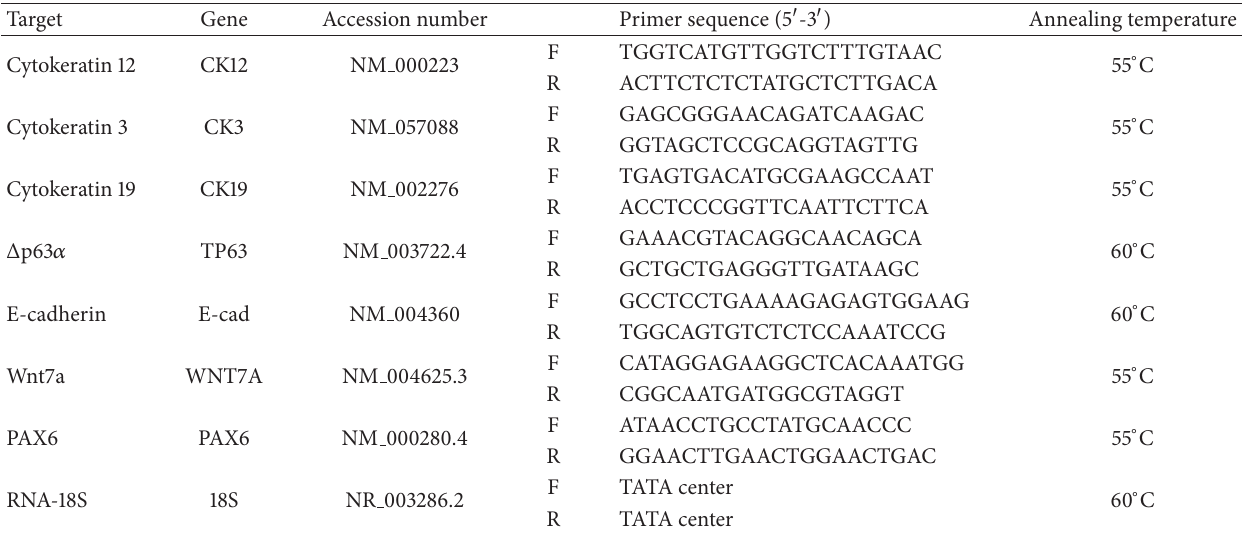
Table 2: Primers and